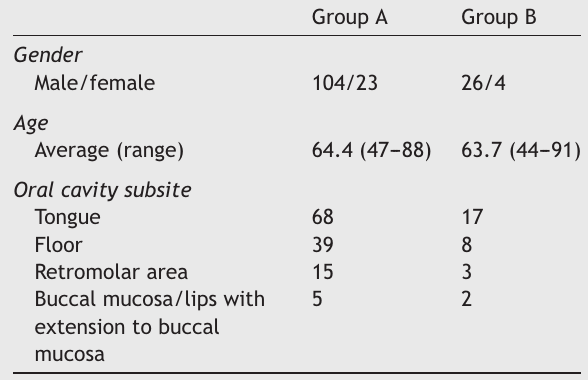
Demographics and occurrence subsites.